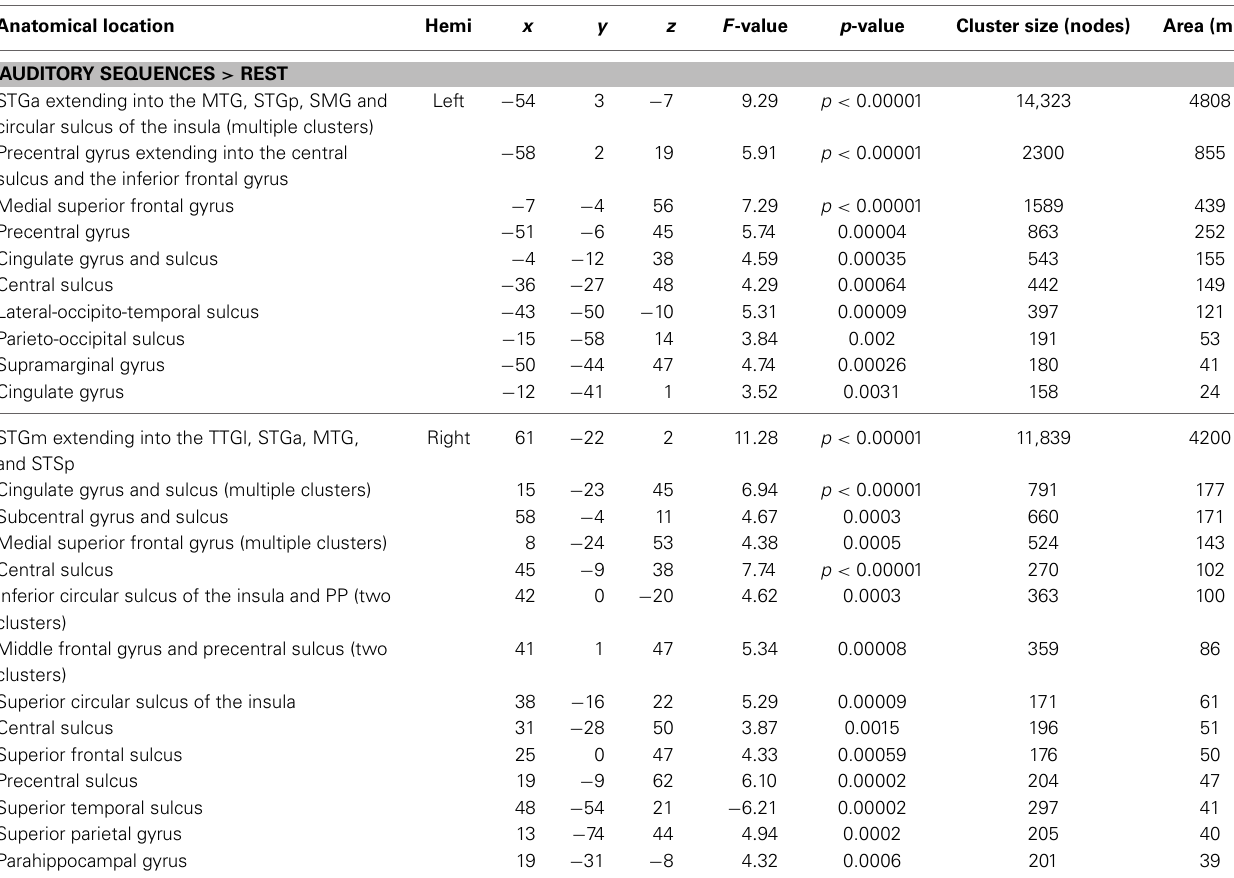
Table 3 | FWE-corrected whole-brain for the speech perception network. Anatomical